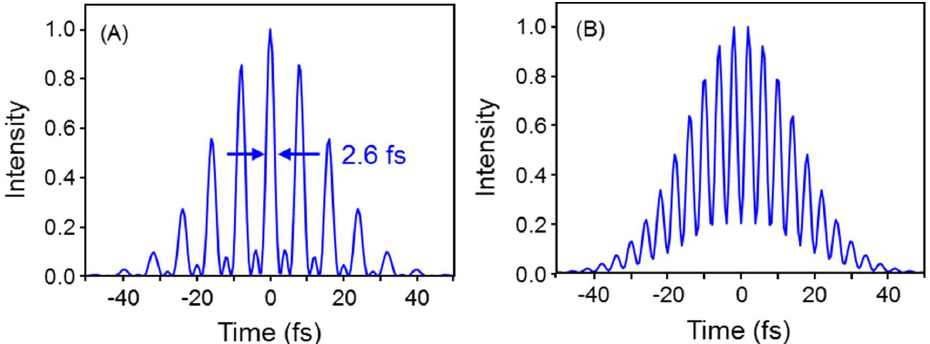
Figure 5. Temporal profile of the pulse train. ( A ) No phase shift ( B ) phase for the anti-Stokes emission is shifted by π at 240 nm.